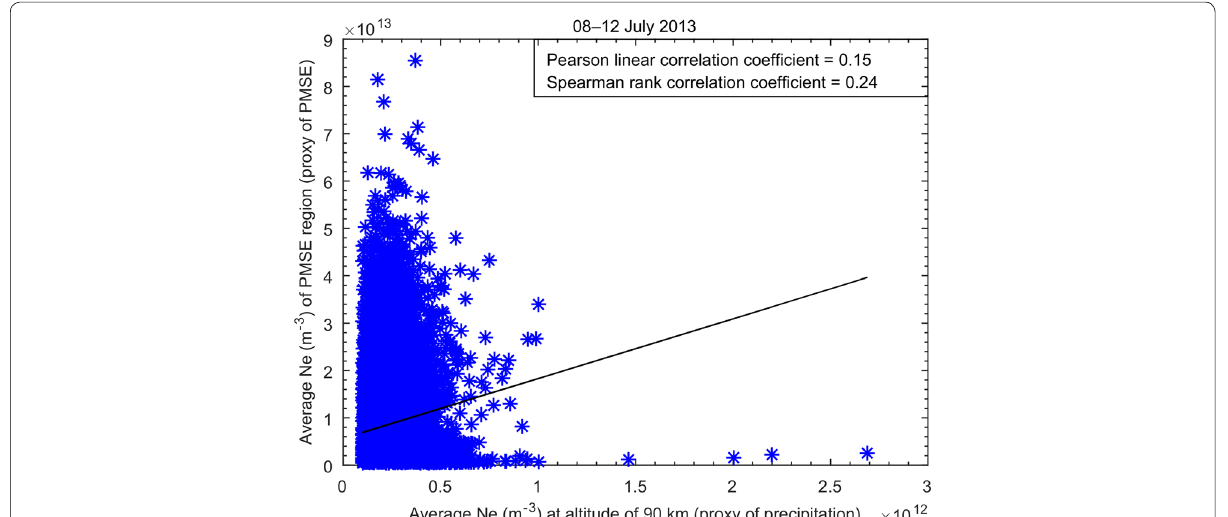
Fig. 6 Scatter plot of average N e at altitude of 90 km (proxy of precipitation) versus average N e in PMSE region (proxy of PMSE) for all data points combined having simultaneous occurrence of PMSE and particle precipitation during 08–12